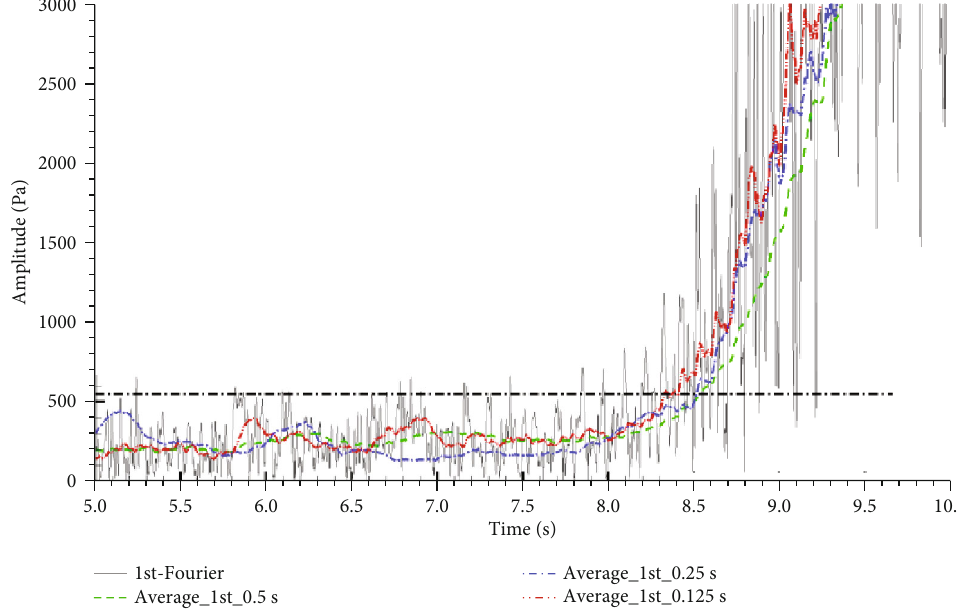
Figure 10: Mean amplitude of the fi rst-order harmonic of the total pressure during the stall